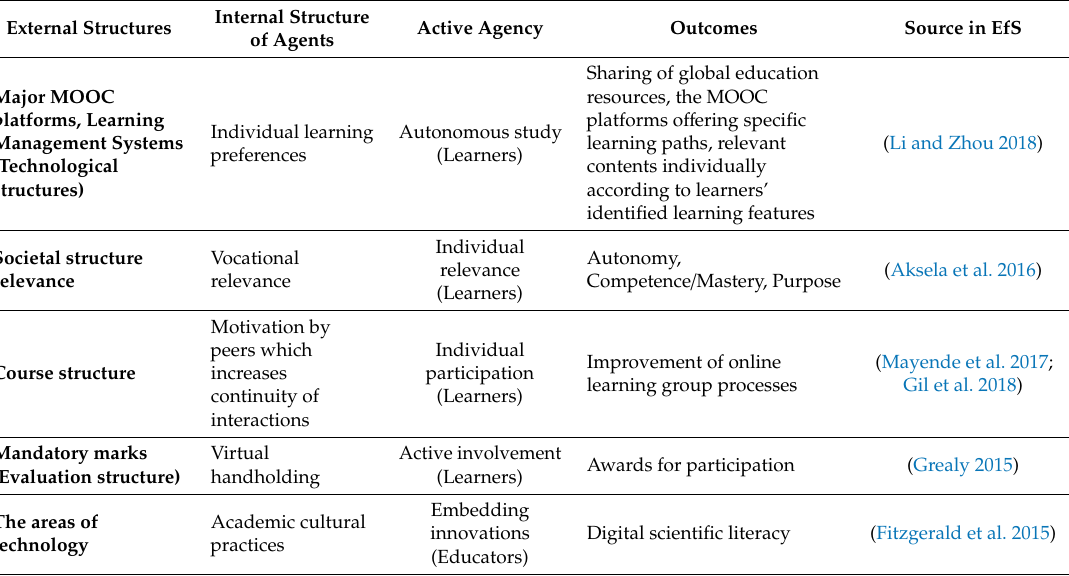
Table 3. Structuration constituents among agents and